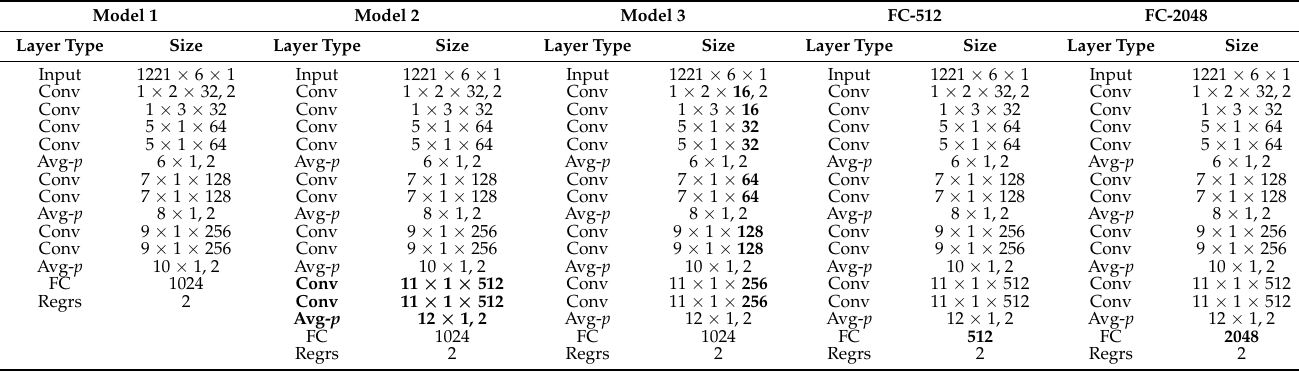
Table 2. CNN configurations (shown in columns). The depth of the configurations increases from the left (Model 1) to the right (Model 2), as more layers are added. Besides, the number of filters decreases from Model 2 to Model 3. Changes are shown in bold. The aim of model “FC-512” and “FC-2048” is to compare the performance between models with different numbers of hidden units in the fully connected layer. The convolutional layer is abbreviated as “Conv” and layer parameters are denoted as “length × width × number of filters, stride”. The average-pooling layer is abbreviated as “Avg- p ” and layer size is denoted as “length × width, stride”. “FC” and “Regrs” represent a fully connected layer and a regression layer,